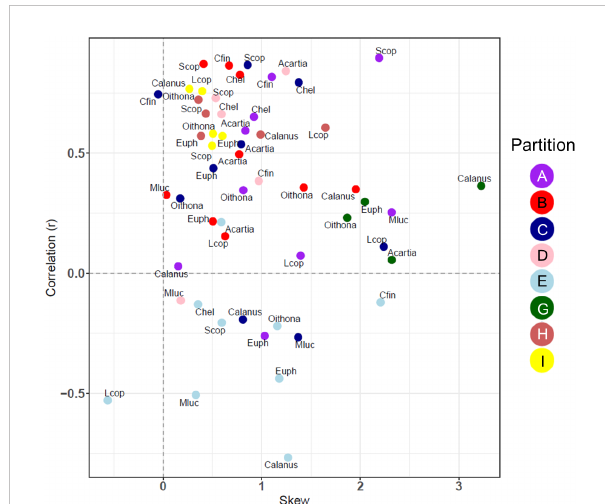
FIGURE 8 The correlation coef fi cient (r) and the skewness of the model error distribution between model and in situ species level data for 8/10 of the zooplankton partitions. Positive skew values indicate an error distribution towards model underestimation and vice versa . Each partition cluster is represented by a different color and are labelled with an abbreviation for each species or species. Calanus, Calanus spp.; Oithona, Oithona spp.; Acartia, Acartia spp.; Mluc, Metridia lucens ; Chel, Calanus helgolandicus ; C fi n , C. fi nmarchicus ; Euph, Euphausiacea; Scop, small copepods; Lcop, Large